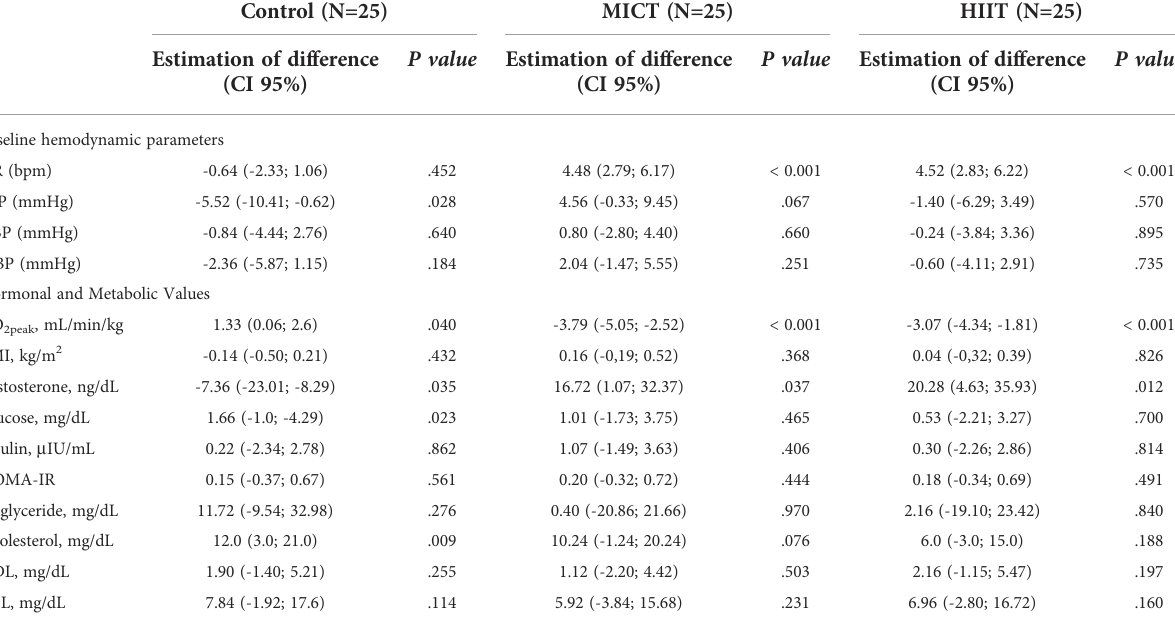
TABLE 2 Intragroup comparison of baseline hemodynamic, hormonal and metabolic parameters obtained before and after the 16-wk of physical